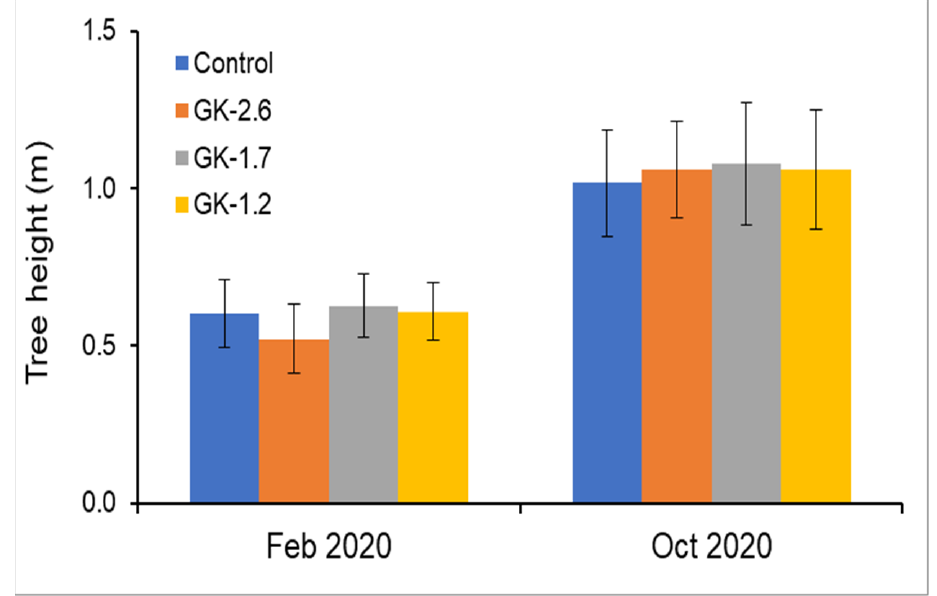
Figure 6. Total tree height at the beginning and at the end of the growing season in 2020. GK-1.2, GK-1.7 and GK-2.6 indicate the Grass Killer treatments at 1.2, 1.7 and 2.6 km per hour working speeds, respectively. Control = hoeing machine. No significant differences were recorded between treatments according to Tukey–Kramer HSD test ( p < 0.05). Data are means ± standard deviation of 30 replicates for Control and 10 for each forward speed of Grass Killer (GK) treatment.